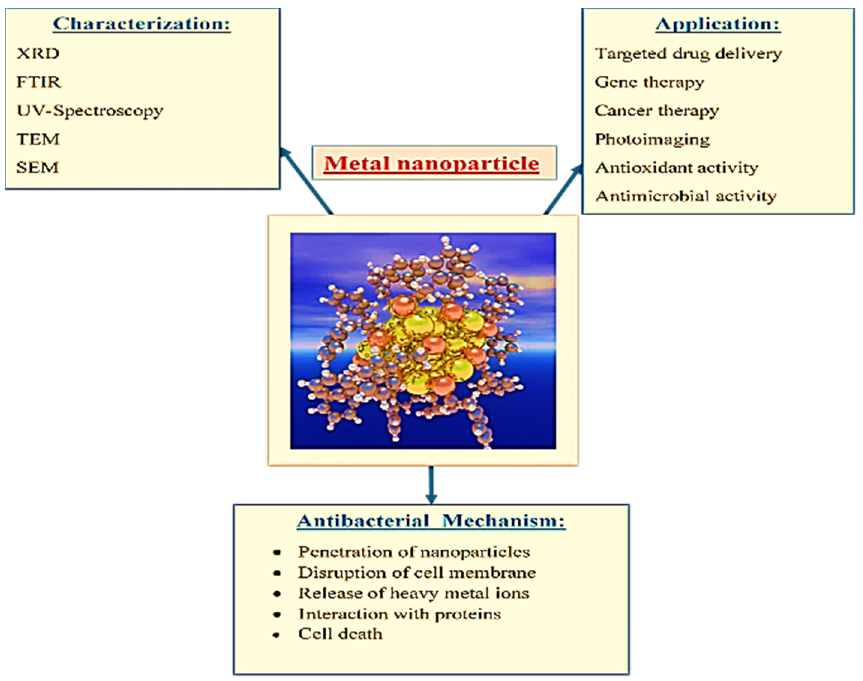
Figure 3. Characterization of metal nanoparticles using different instrumental-based techniques.